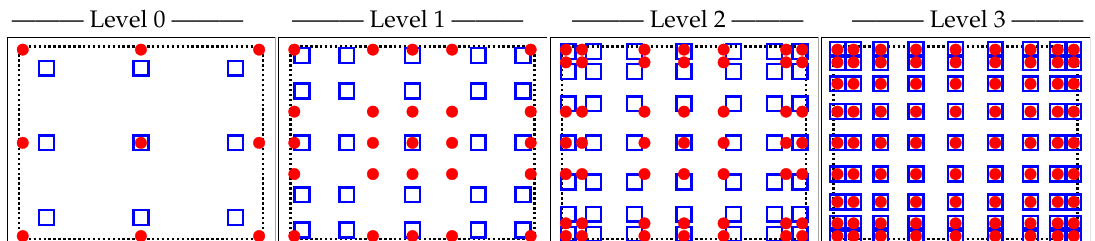
Figure 5. Quadrature points (cid:3) and points where the discrete values of the random field are to be generated on one element for model problem 1.